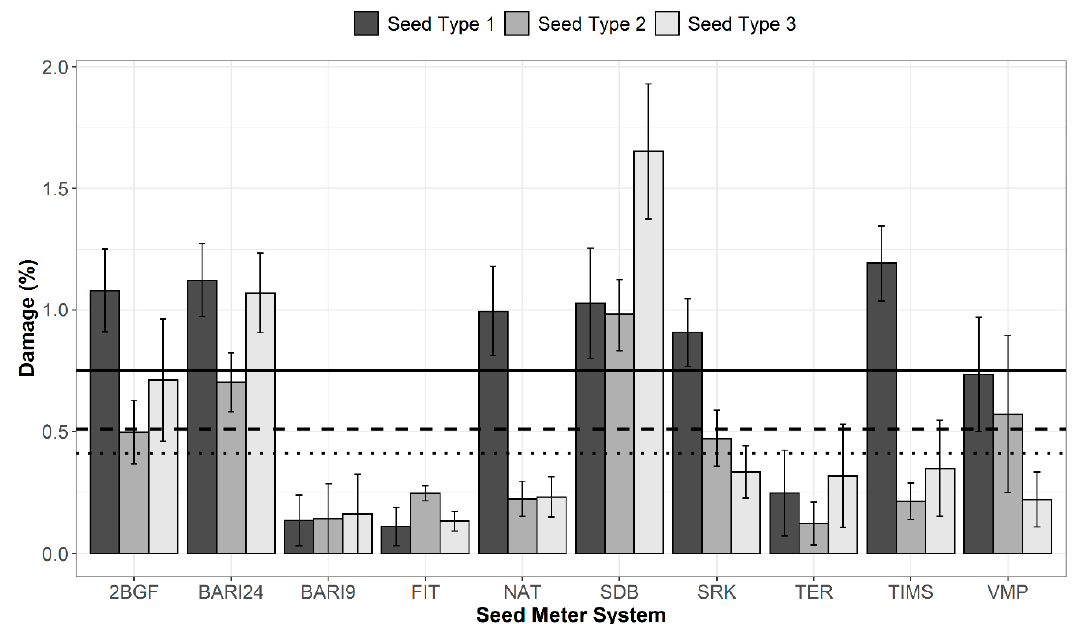
Figure 5. Mean percentage seed damage caused by the different meters for the three seed types (Seed type 1—medium round, Seed type 2—small drop-shaped and Seed type 3—flat and large) and corresponding standard errors. Solid, dotted and dashed horizontal lines show mean level of damage for seed types 1, 2 and 3, respectively.